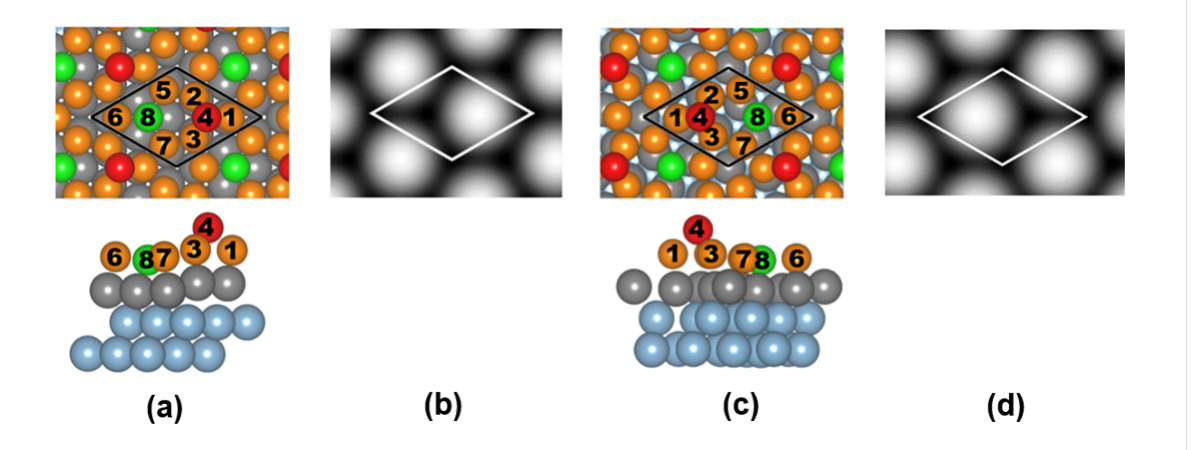
Figure 3: (a) Top and side views of the relaxed model of (2×2) germanene on (3×3) Al(111). The black cell represents a (3×3) reconstruction with respect to the Al(111) surface. (b) Calculated STM image generated from the local density of filled states and simulated in a constant current mode at a distance of ≈ 2 Å above Ge(4) for the model in (a). (c) Top and side views of the relaxed model of (2×2) germanene on ( √ 7× √ 7) Al(111). The black cell represents a ( √ 7× √ 7) reconstruction with respect to the Al(111) surface. Note that the orientation of the Al(111) substrate is different in (a) and (c). (d) Calculated STM image generated from the local density of filled states and simulated in a constant current mode at a distance of ≈ 2 Å above Ge(4) for the model in (c). The hexagonal structure is consistent with the experimental results in Figure 2. The highest Ge atom is colored red and labeled Ge(4), the lowest Ge atom is colored green and labeled Ge(8), the other Ge atoms are colored orange, Al atoms are colored light blue, except for the first layer Al atoms which are colored grey. The Ge(4) atom gives rise to the hexagonal pattern observed by STM.